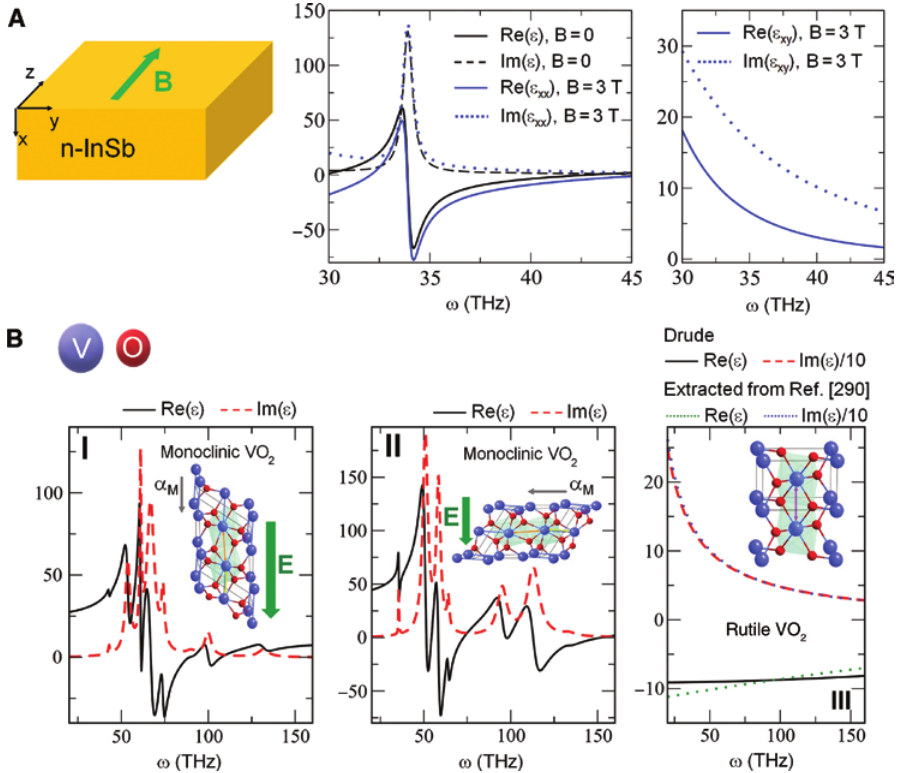
Figure 26: Tunable photonic responses in the PhP